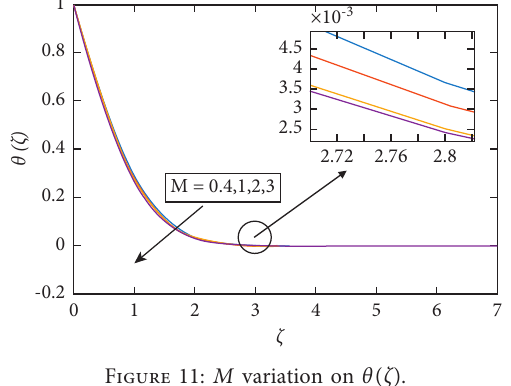
Figure 14: R variation on θ ( ζ ) .